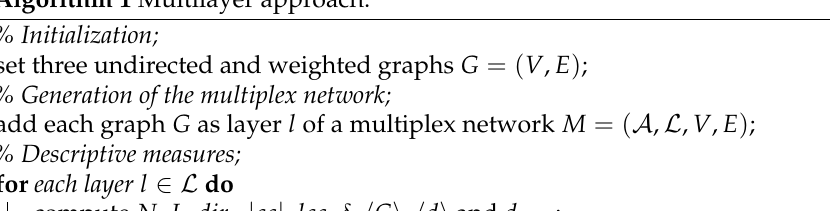
Algorithm 1 Multilayer approach.